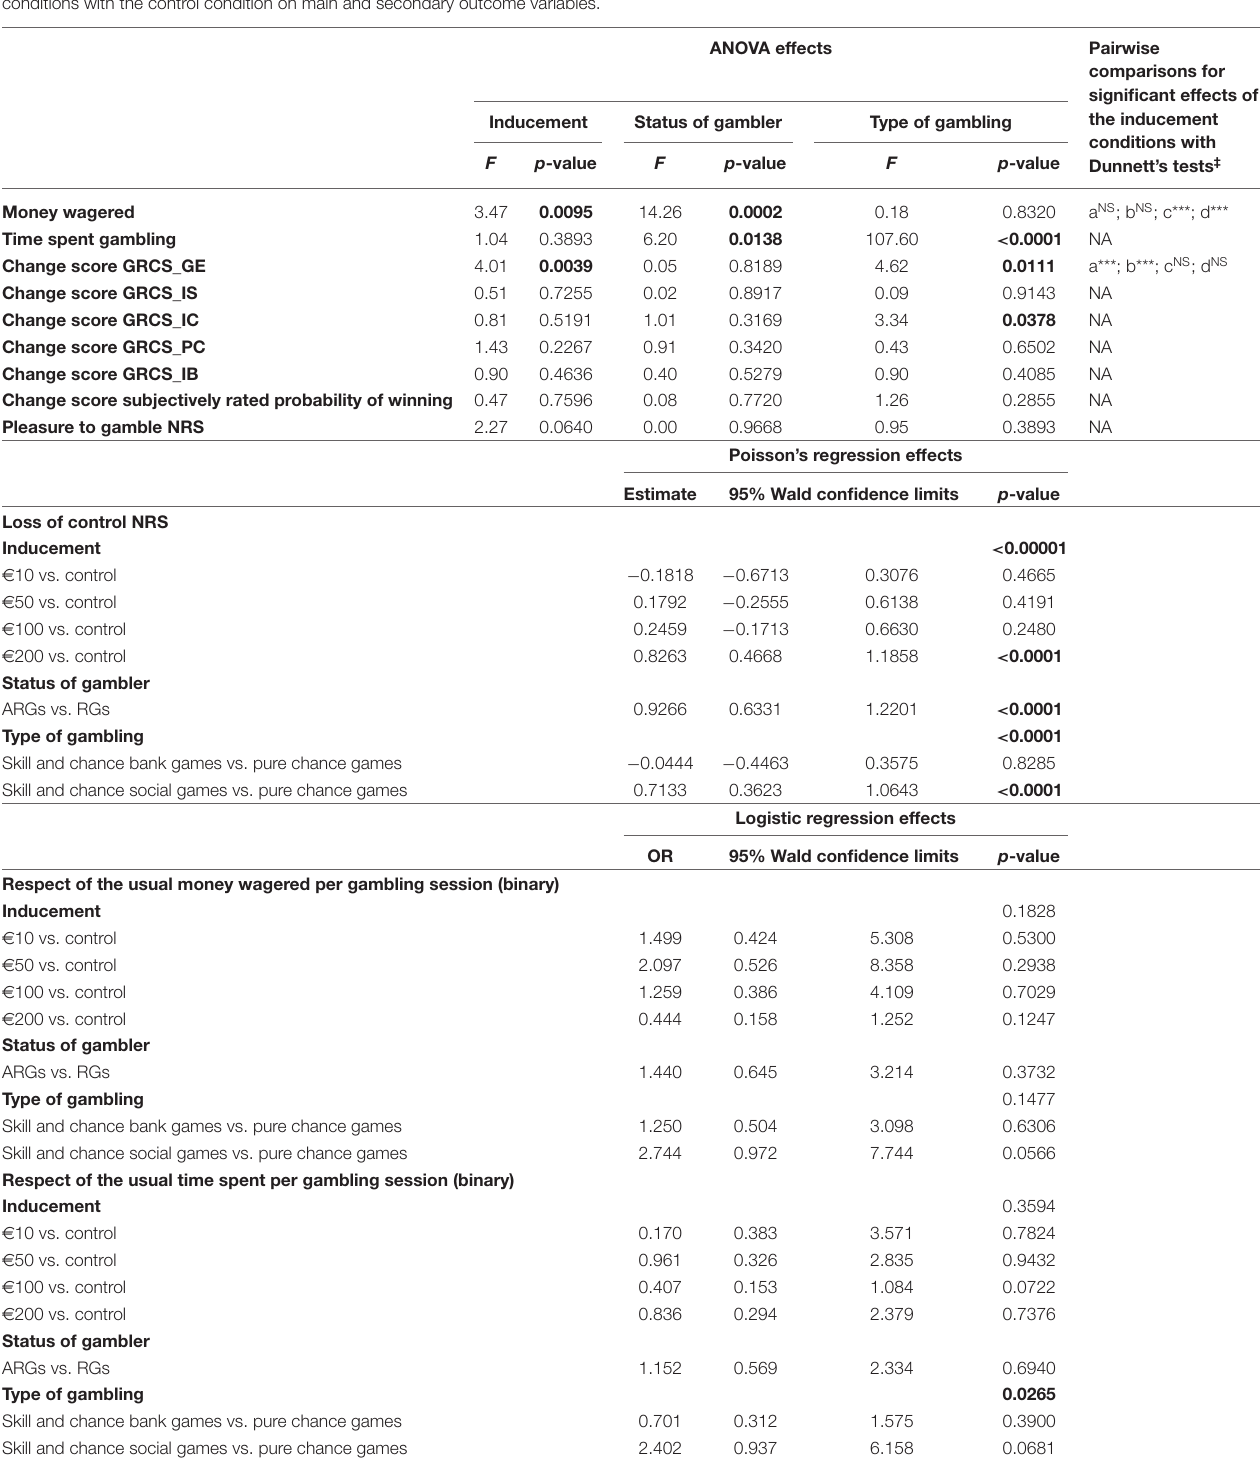
TABLE 4 | Results of the ANOVAs and regressions adjusted for the status of gamblers and the type of preferred gambling activity, comparing the 4 experimental conditions with the control condition on main and secondary outcome variables.